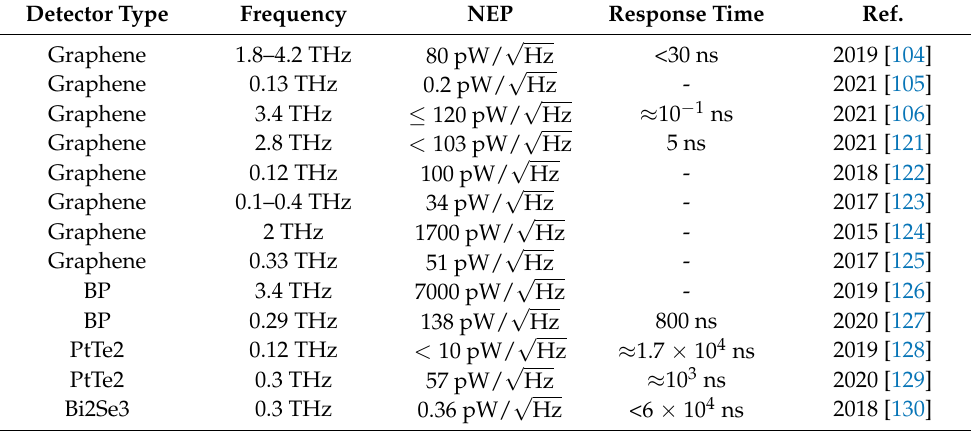
Table 3. Summary of THz